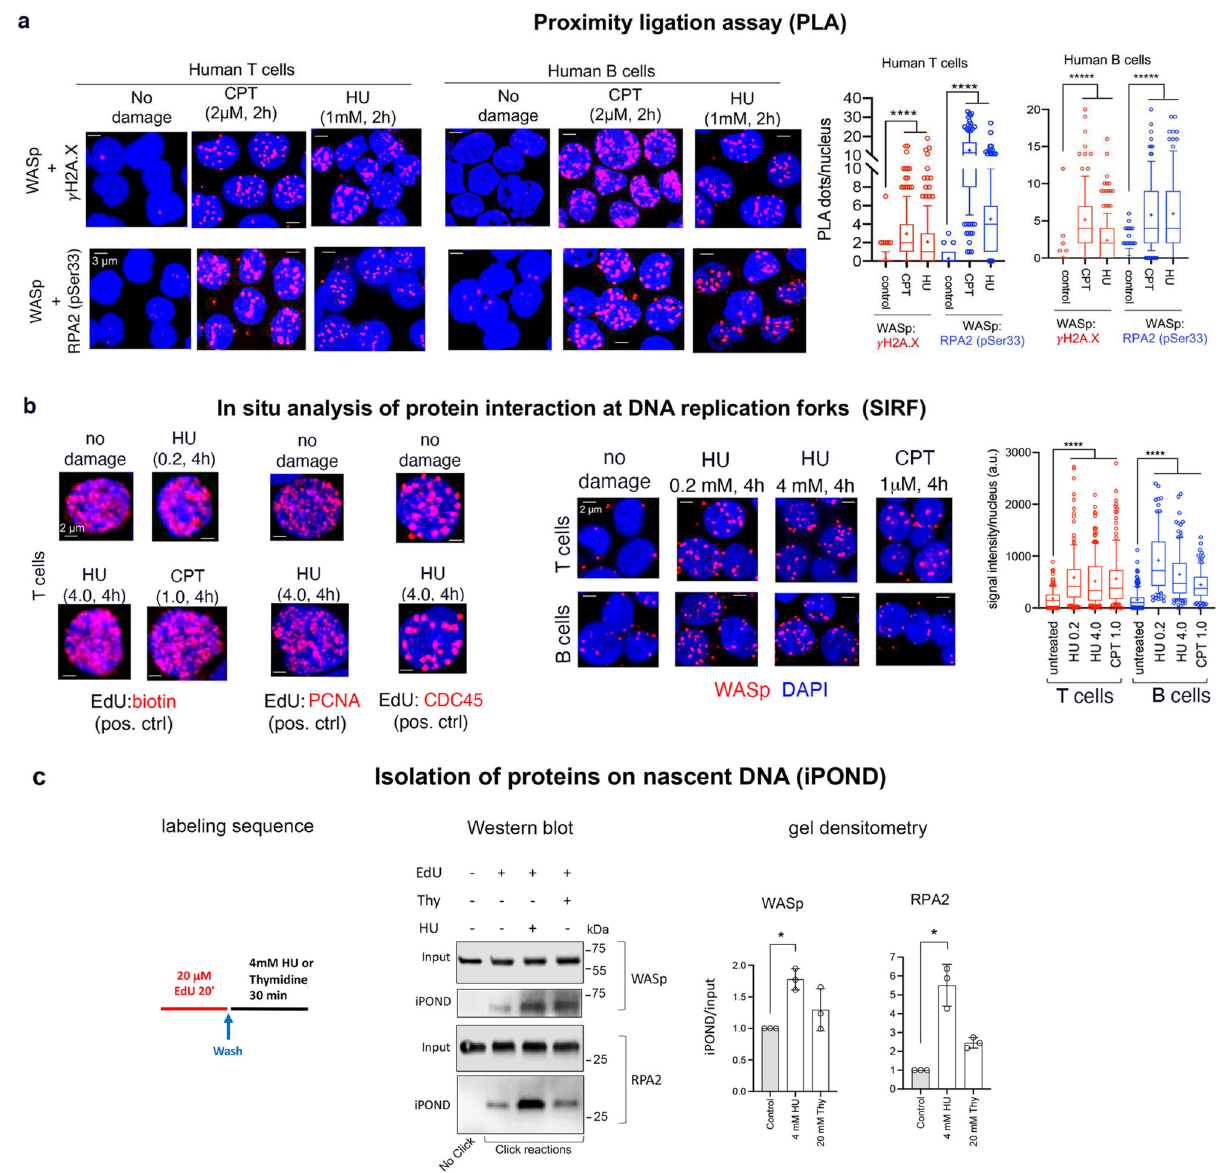
Fig. 1 WASp is a DNA stress-response protein. a Proximity ligation assay (PLA). Confocal immuno fl uorescence (IF) microscopy showing a representative set of collapsed composite IF images from a z-stack of ~30-40 images acquired per optical fi eld. Shown are the PLA signals between the indicated interacting proteins induced by the indicated genotoxins or no damage control in human T and B cells, along with their corresponding PLA statistics in box- and-whisker plots (whiskers @10 – 90%, horizontal bar denotes median, “ + ” denotes mean). In both panels, unpaired, two-tailed, Mann-Whitney nonparametric p values ****<0.0001, n = 150 cells/condition. Scale bar: 3 μ m. b In situ analysis of protein interactions at replication forks (SIRF). Right , Representative z-stack collapsed composite confocal IF images showing SIRF signals between 5-ethynyl-2 ’ -deoxyuridine (EdU)-labeled nascent DNA and the indicated protein in steady-state (no damage) or after HU- or CPT-induced DNA perturbation, along with their corresponding statistics ( n = 100 cells). Left , representative SIRF images of positive and negative controls (ctrl), under replicative stress or no stress/damage. Statistical details as per a . Scale bar: 2 μ m. c Isolation of proteins on nascent DNA (iPOND). Left , schematic of nascent DNA labeling, in which red line denotes DNA labelled with EdU, followed by black line denoting chase into media containing either hydroxyurea (replication stressor) or thymidine (control for true replication proteins that will not enrich in this sample due to EdU displacement). Middle , shows Western blots of input and iPOND puri fi ed proteins under indicated conditions, including no EdU sample (no-click negative control). Right , bar graphs depict gel densitometric quantitation of iPOND/Western blot signals normalized to their respective inputs. n = 3, + SEM. Mann-Whitney unpaired two-tailed nonparametric p -value *<0.01. Source data are provided as a Source Data fi